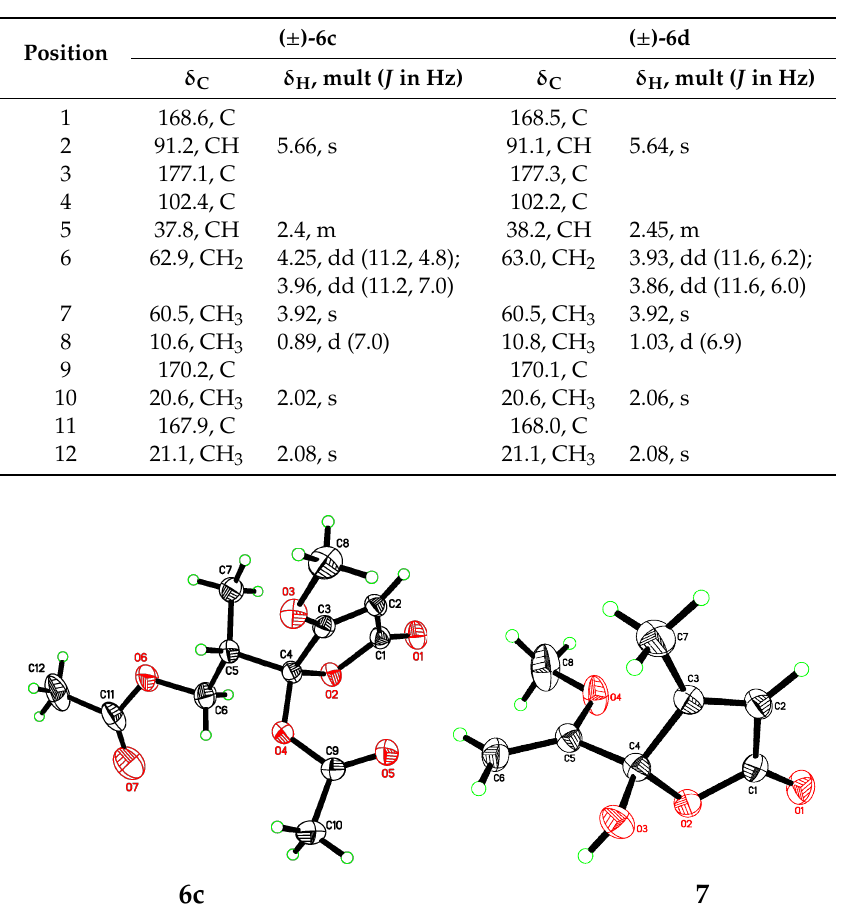
Figure 5. X-ray ORTEP diagrams of 6c and 7 .